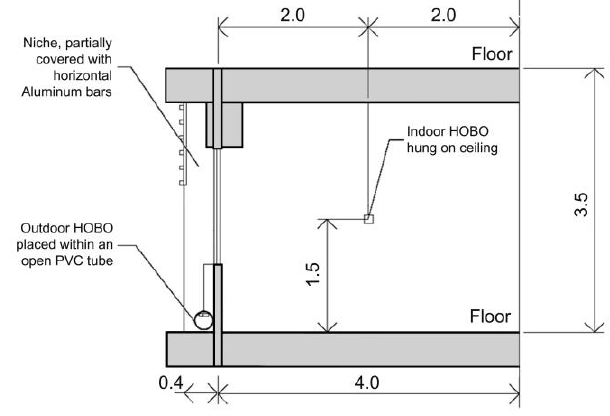
Fig. 7. Section of the A apartment unit.